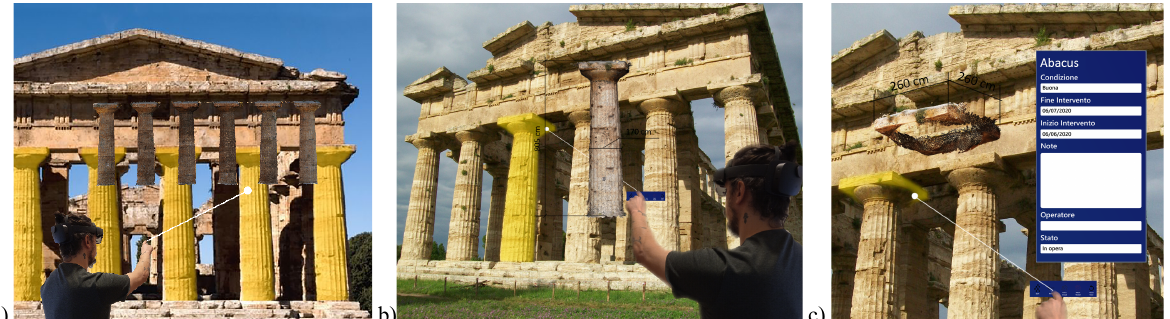
Table 1. Temple of Neptune: classification levels, metrics and point cloud resolutions at each level.